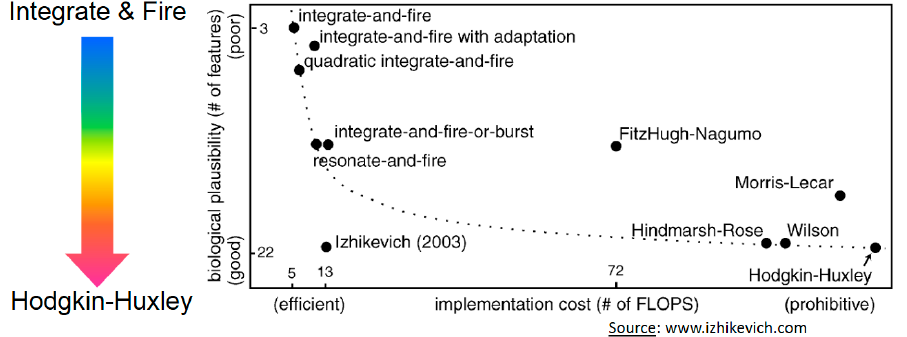
Figure 2. Neuron models in the literature classified following the biological plausibility and the implementation cost. The figure was extracted from www.izhikevich.com. An electronic version of the figure and reproduction permissions are freely available at www.izhikevich.com.